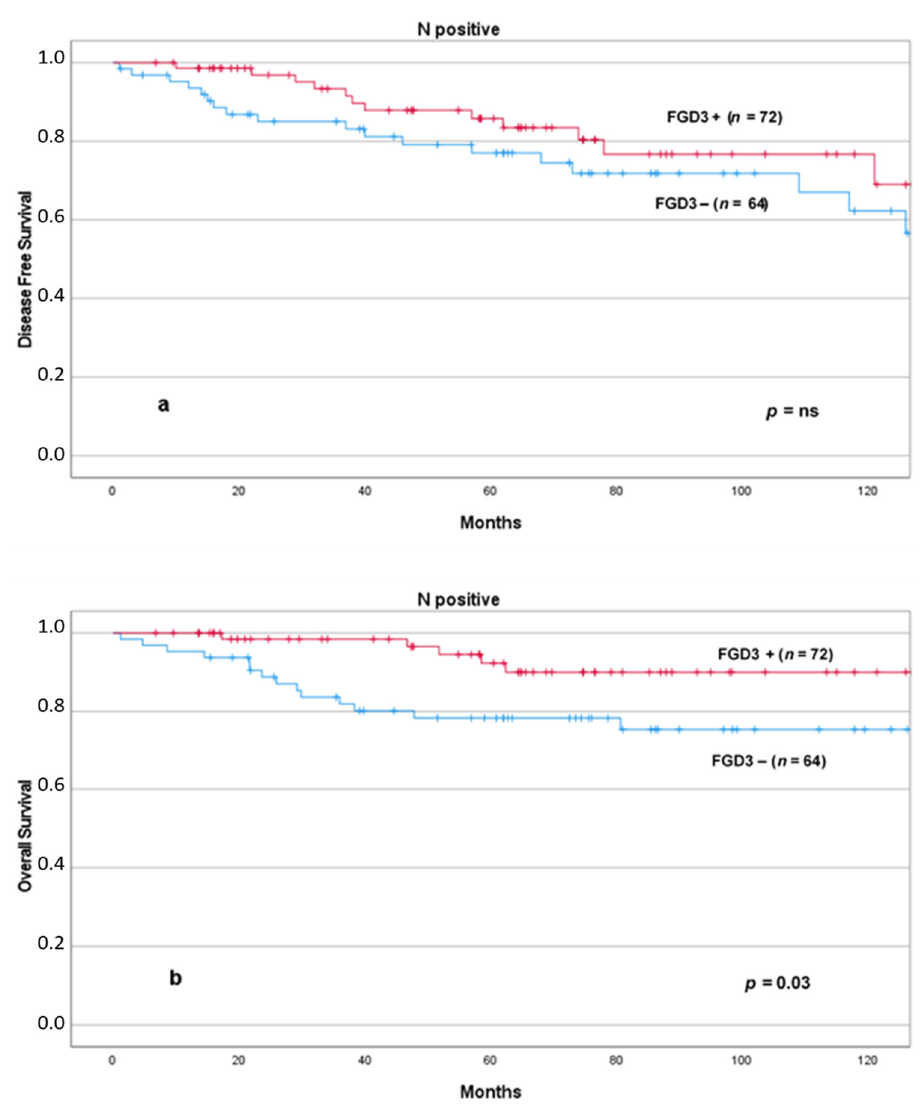
Figure 6. DFS ( a ) and OS ( b ) according to FGD3 expression in node positive patients. Abbreviations: FGD3+: high FGD3 expression; FGD3 − : low FGD3 expression. Similarly, low FGD3 expression was associated with significantly reduced DFS and OS in patients with Luminal A tumors (Figure 7) and OS in patients with Luminal B tumors (Figure 8).